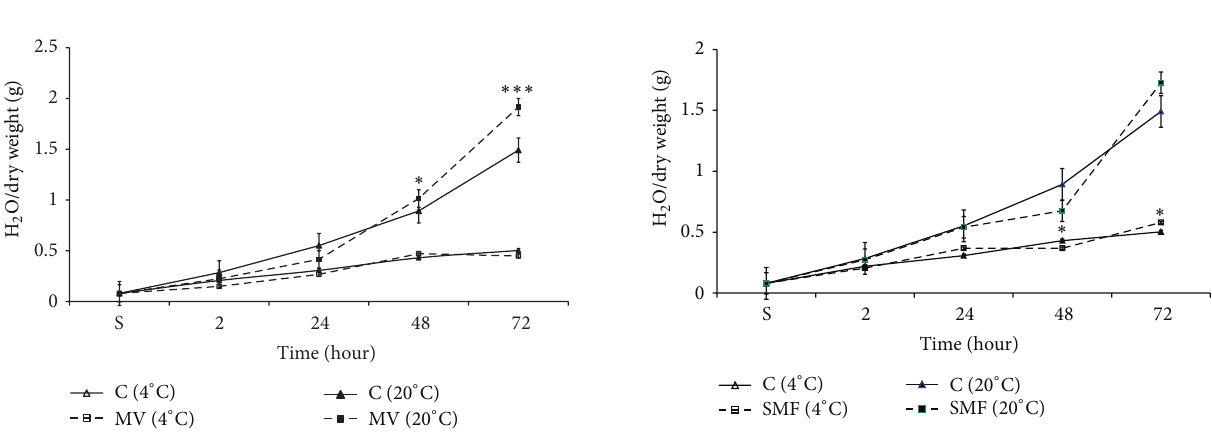
Figure 5: Time-dependent changes in seed hydration during 72 hours of incubation in MV (15Hz; 30 dB) treated (gray column) and nontreated Sham (clear column) DW in cold (4 ∘ C; clear/grey with no pattern markings) and warm (20 ∘ C; clear/grey with horizontal pattern markings) conditions. The time (in hours) of seeds incu- bation on abscissa and the value of seed hydration (mg of H 2 O for 1mg of dry weight) on ordinate are presented. The results are shown as mean ± SEM ( 𝑛 = 300 ) from three independent experiments, 100 seeds from each experiment. ∗ 𝑃 < 0.05 , compared with Sham, ∗∗ 𝑃 < 0.01 .